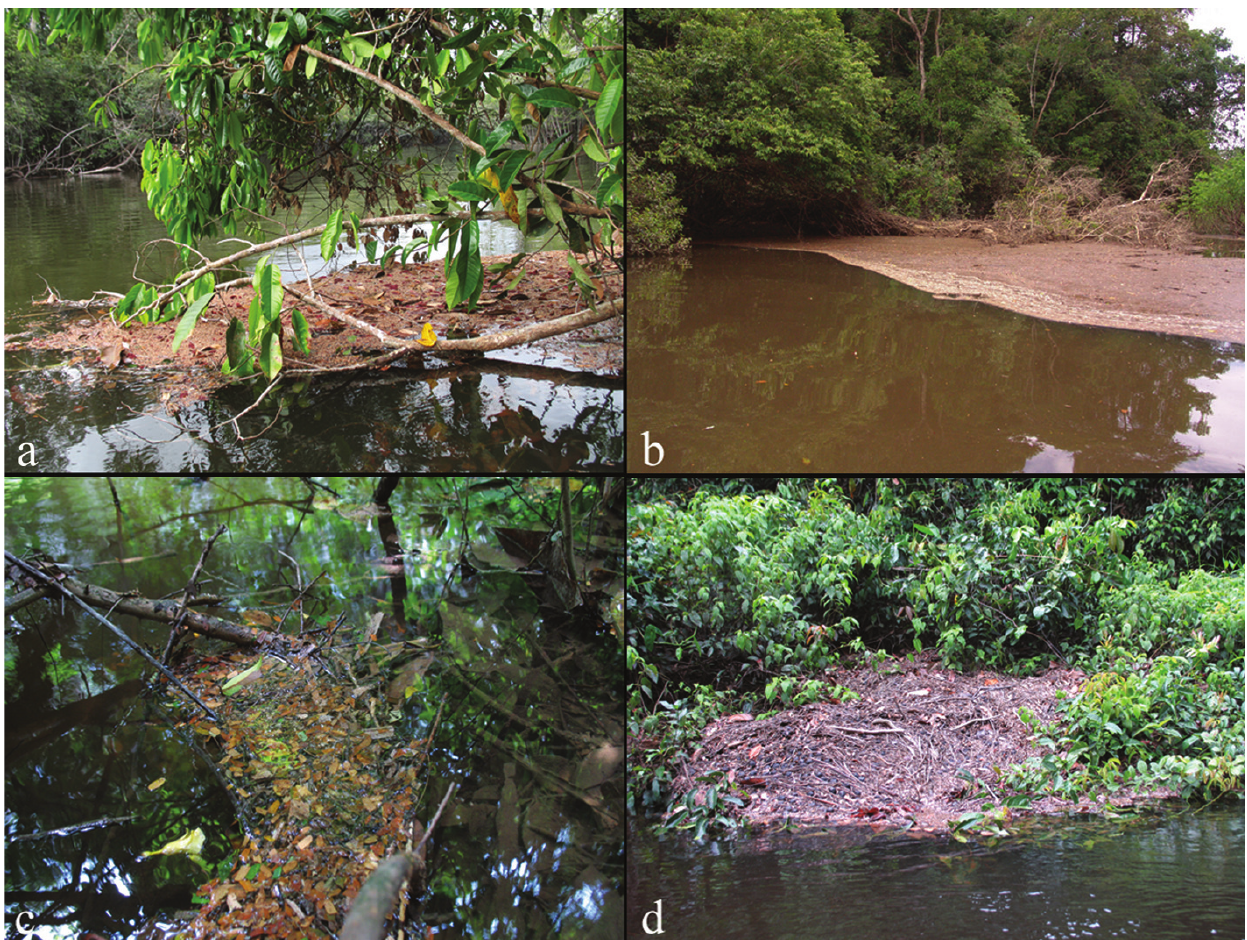
Fig. 1. Floating litter banks of different dimensions and means of accumulation ( i.e ., diverse retention mechanisms): ( a ) floating litter banks retained by branches of riparian vegetation; ( b ) a large floating litter bank retained in a “ria lake” condition at the confluence of the Aliança Stream with the Branco River; ( c ) a small floating litter bank close to the margin of a 4 th -order stream in the Urubu River basin; and ( d ) a large floating litter bank almost completely out of the water in a stream in the Urubu River basin during the dry